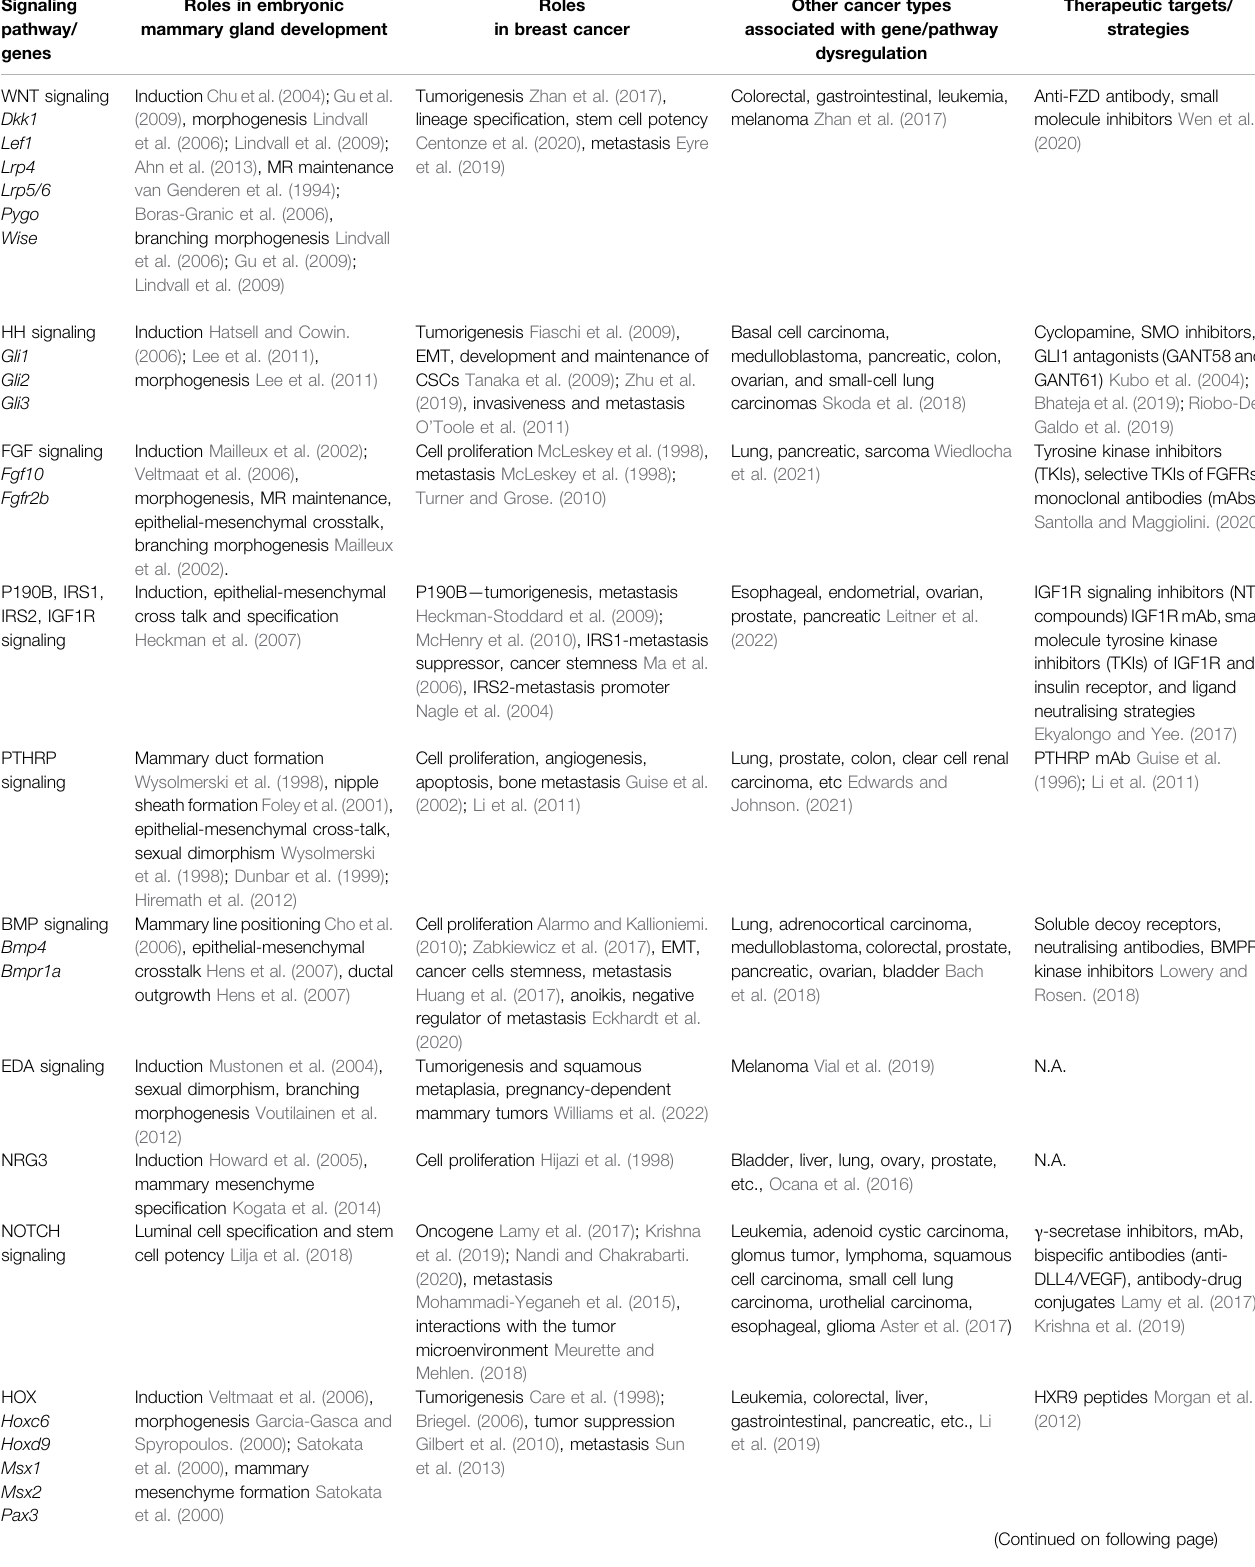
TABLE 1 | Genes and signaling pathways critical for embryonic mammary gland development, their corresponding role in breast cancer, involvement in other cancers, and available therapeutic targets and strategies. Signaling